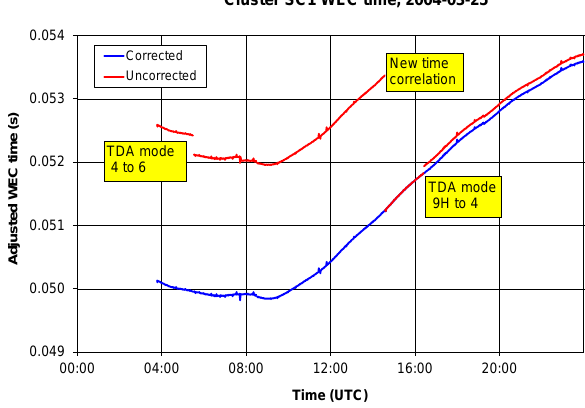
Fig. 5. Final validation of time corrections. The chart shows WEC data time stamps modulo 0.1s, and are adjusted for the average rate of drift of the WEC clock. The uncorrected time shows jumps due to the change in OFFSET at telemetry data acquisition (TDA) mode changes, and due to change in DIFF at a new time correlation. These jumps are removed when the corrections are